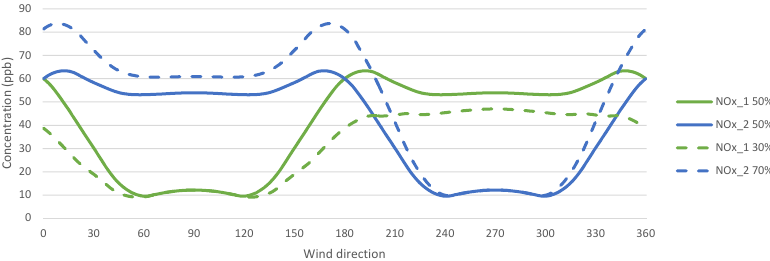
Figure 13. Theoretical calculation of the concentration for the two receptors of a street canyon with two emission segments each covering half the street width and an aspect ratio of one as a function of the emission inhomogeneity and wind direction. Receptor 1 is marked in green and receptor 2 is marked in blue. The inhomogeneity is given as percentages of the total emission for the two segments and the inhomogeneous case is marked with dotted lines.